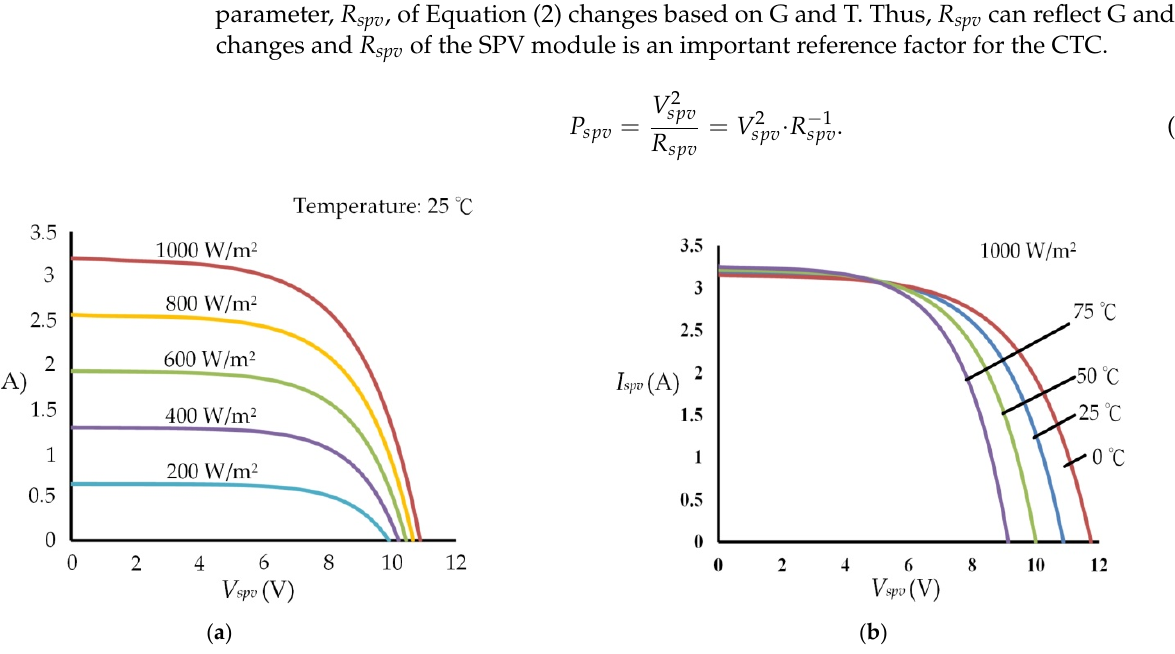
Figure 1. A single SPV module I spv ‐ V spv characteristic curve graph (Everbright, model number Q025). ( a ) T of 25 °C; G of 200, 400, 600, 800 and 1000 W/m 2 , respectively. ( b ) G of 1000 W/m 2 ; T of 0, 25, 50 and 75 °C, respectively.